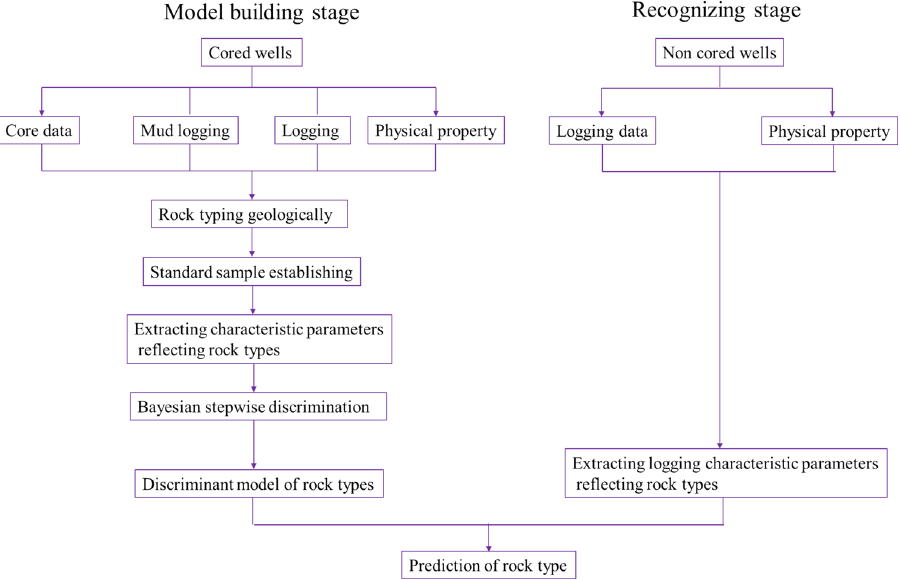
Figure 4. The process chart of Bayesian discriminant method in recognizing rock